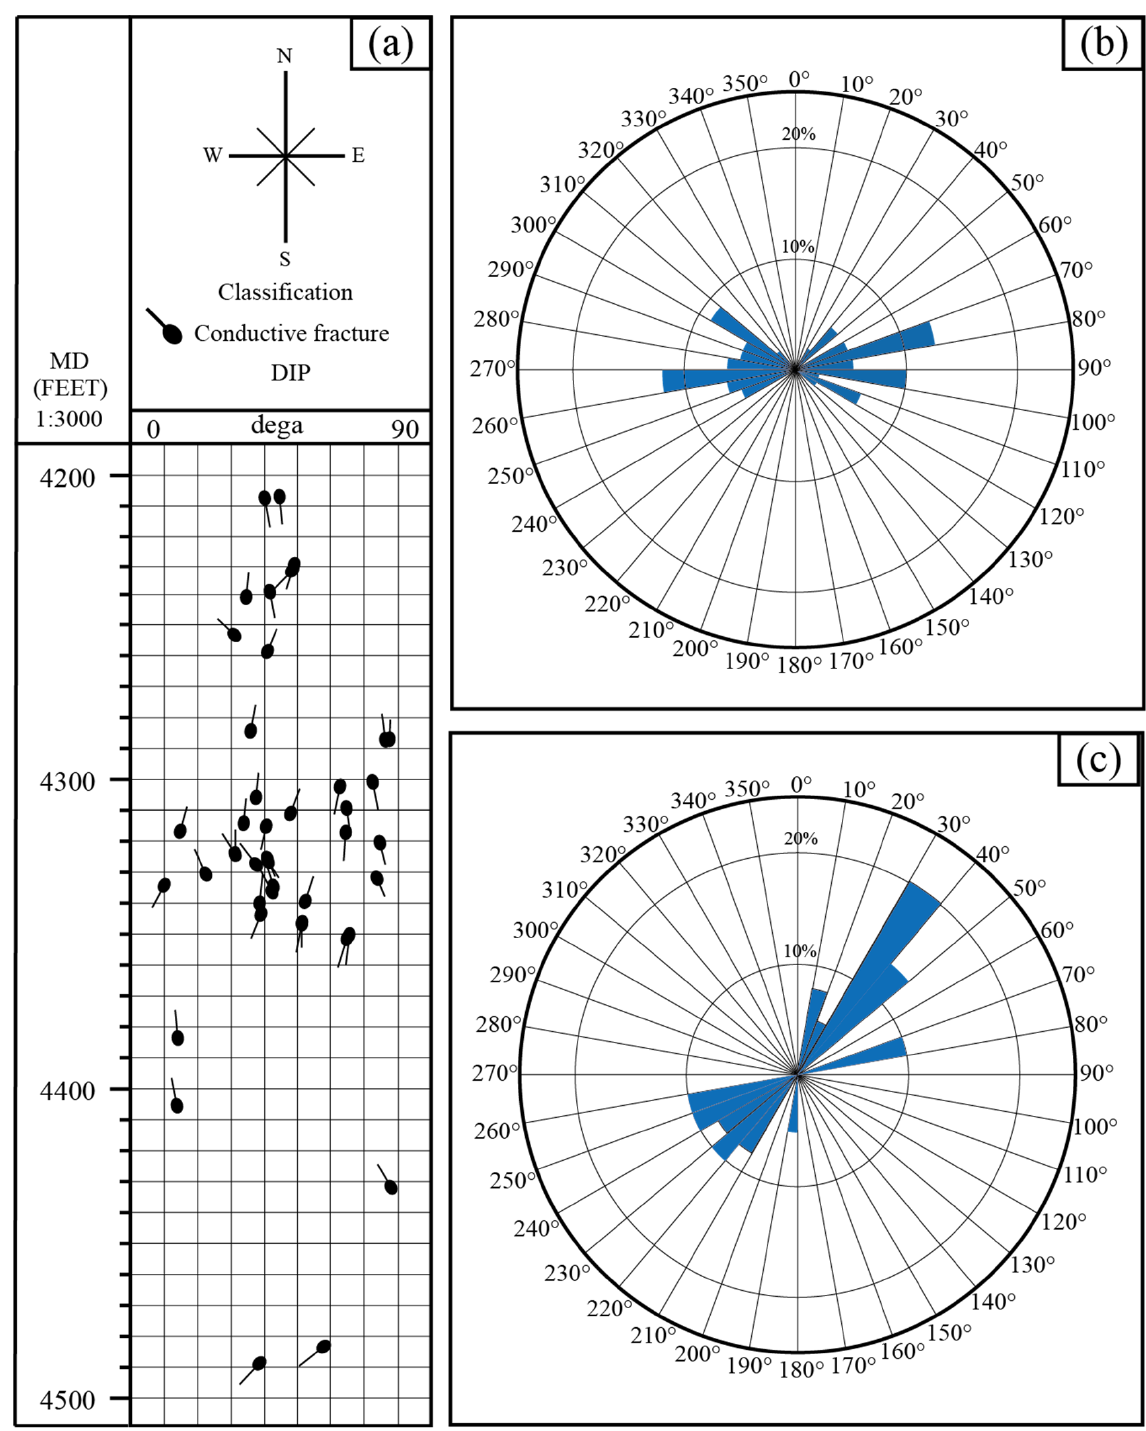
Figure 3. Natural occurring fractures in well M ‐ 2: ( a ) tadpole diagram of identified fractures, ( b ) fracture population dip azimuths, and ( c ) fracture population dip strikes.